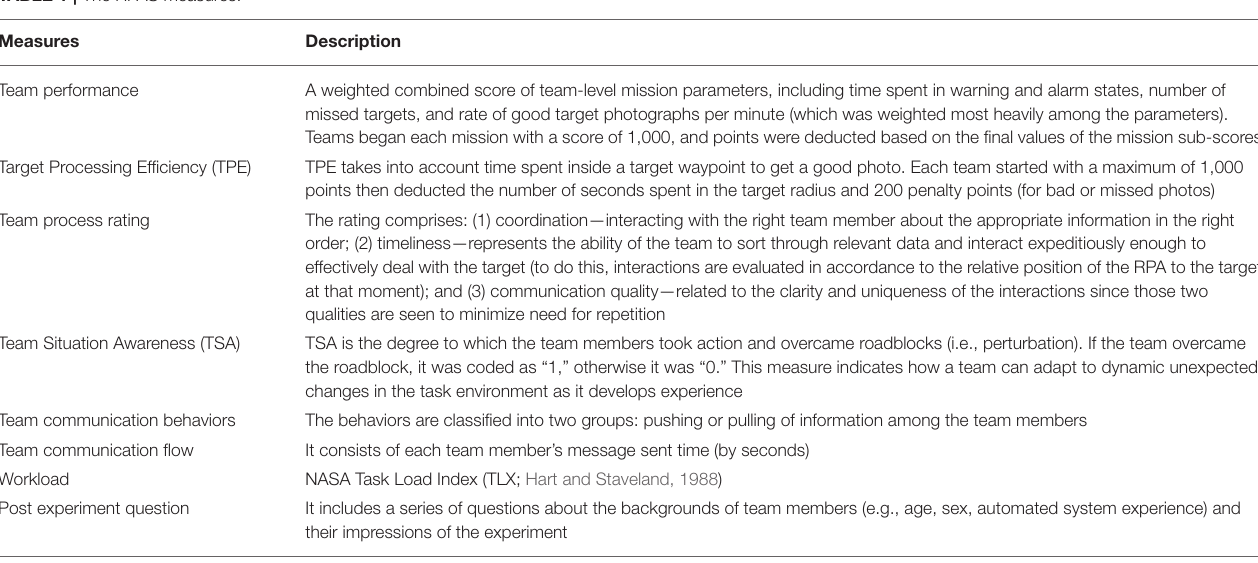
TABLE 1 | The RPAS